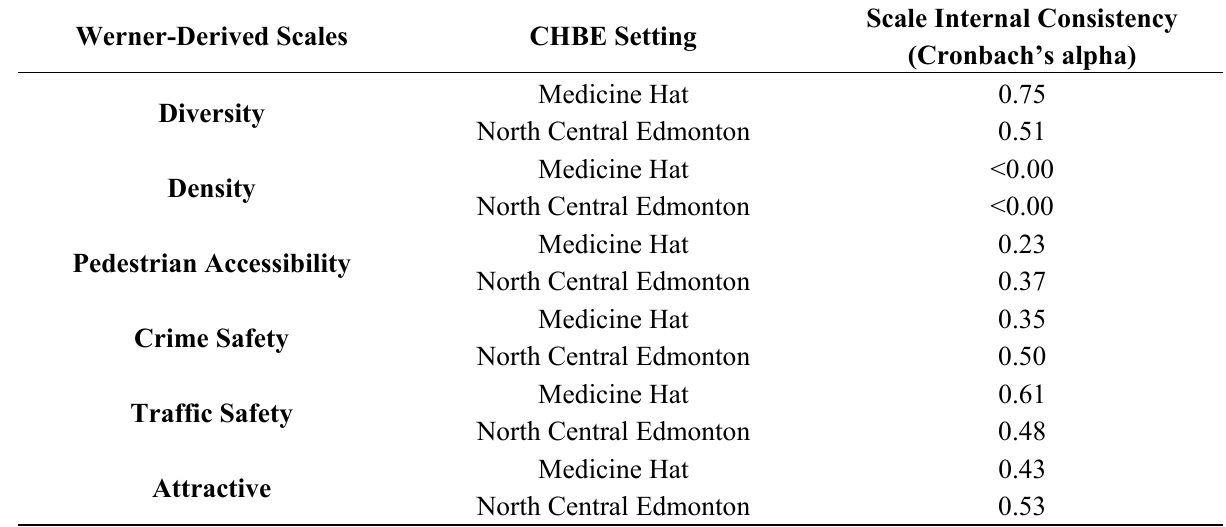
Table 7. Internal consistency of scales informed by methods used by